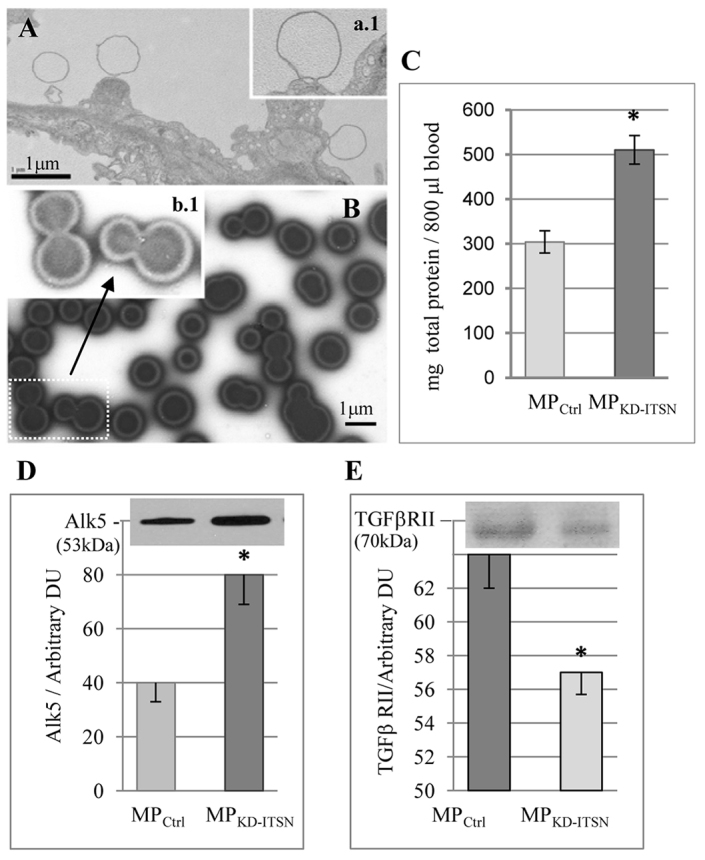
The apoptotic or activated circulating and vascular cells of KD-ITSN mice release elevated levels of microparticles into the bloodstream. (A,a1) EM of a mouse lung endothelial cell (10 days post siRNAITSN delivery) shows small vesicular structures in the lumen of the blood vessel. (B) Negative staining EM of MPKD-ITSN (10 days post siRNAITSN delivery) demonstrates their ability to fuse to each other (b1). (C) Increase in abundance of microparticles at 10 days post siRNAITSN. Total protein amounts are normalized to 800 µl of blood and plotted as the means±s.e.m.; n = 3; *P<0.01. (D,E) Microparticles (15 µl volume; normalized to equivalent µl of blood) were analyzed for the expression of Alk5 and TGFβ-RII, respectively, as above. n = 3; *P<0.01. DU, densitometric units. Scale bars: 1 µm (A,B). All data are representative of three independent experiments.